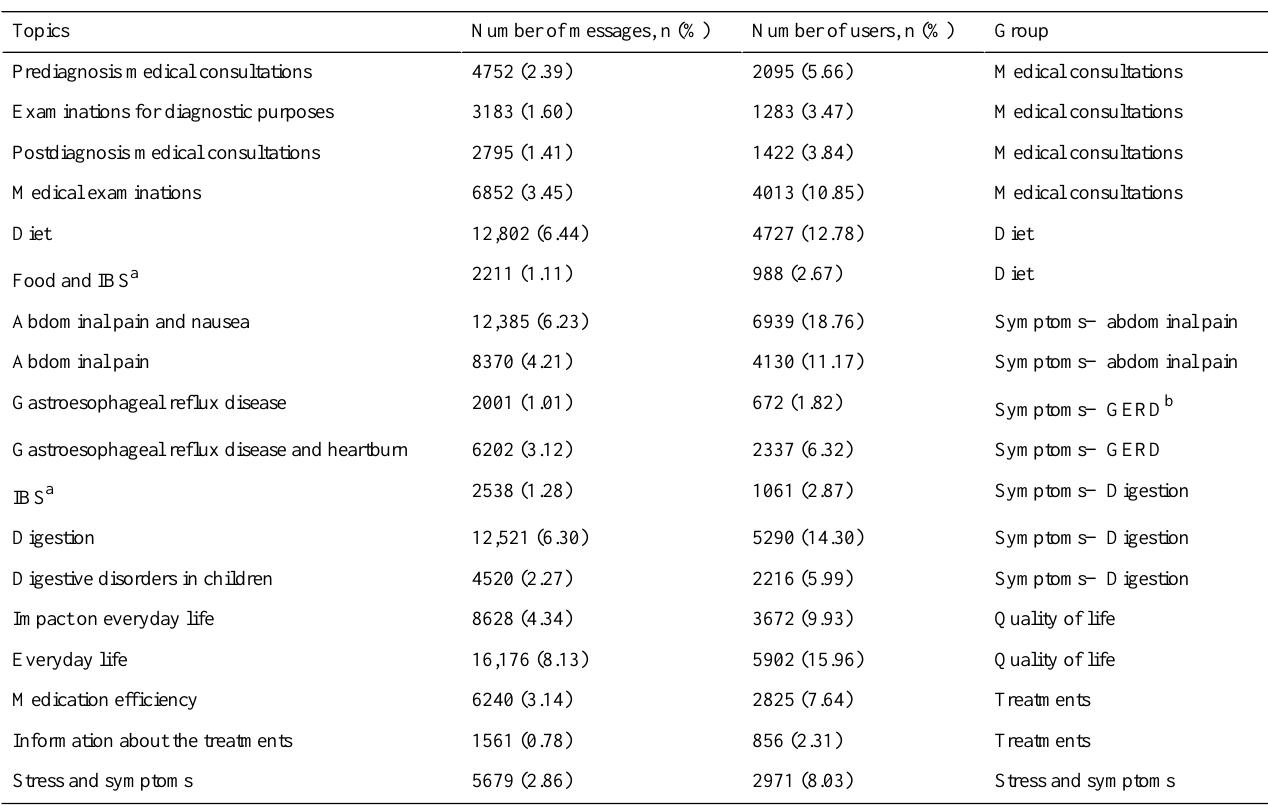
Table 2. List of modeled and merged topics.